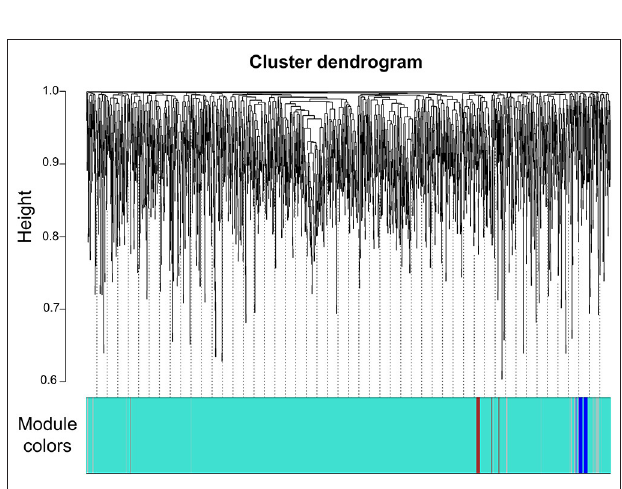
FIGURE 5 | Gene dendrogram. Gene dendrogram and clustered modules coded by four